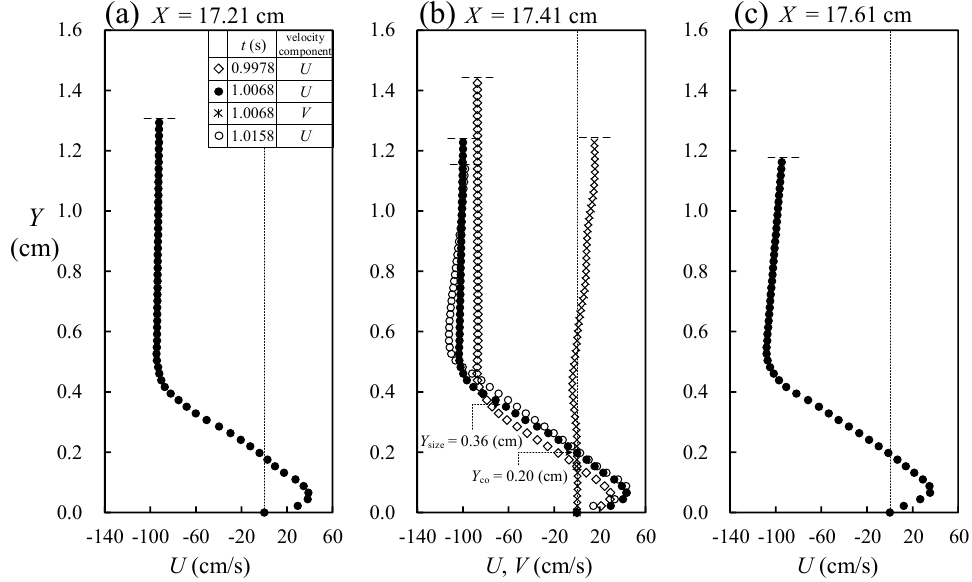
Figure 15. ( a – c ) The velocity profiles U ( Y ) measured at X = 17.21, 17.41 and 17.61 cm for t = 1.0068 s, respectively. Note that two velocity profiles, U ( Y ), for t = 0.9978 and 1.0158 s as well as one velocity profile, V ( Y ), at t = 1.0068 s are also included in ( b ).